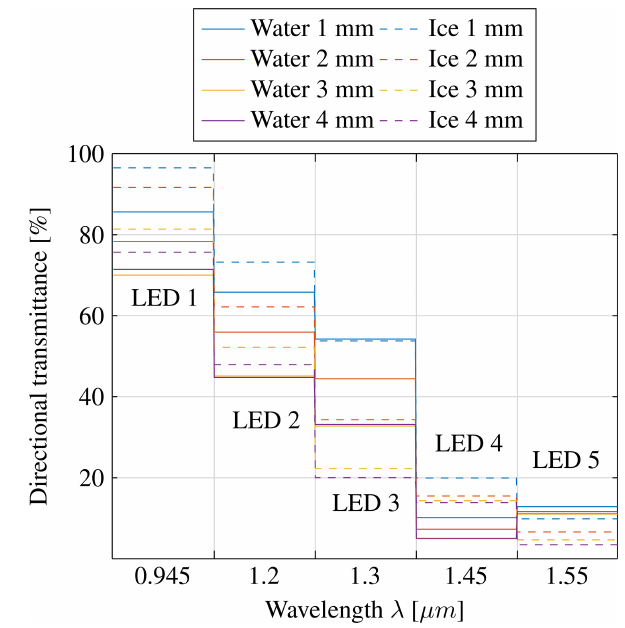
Figure 14. Measured directional transmittance of water and ice at a distance of 5cm with a layer height of 1 to 4mm on a white tile